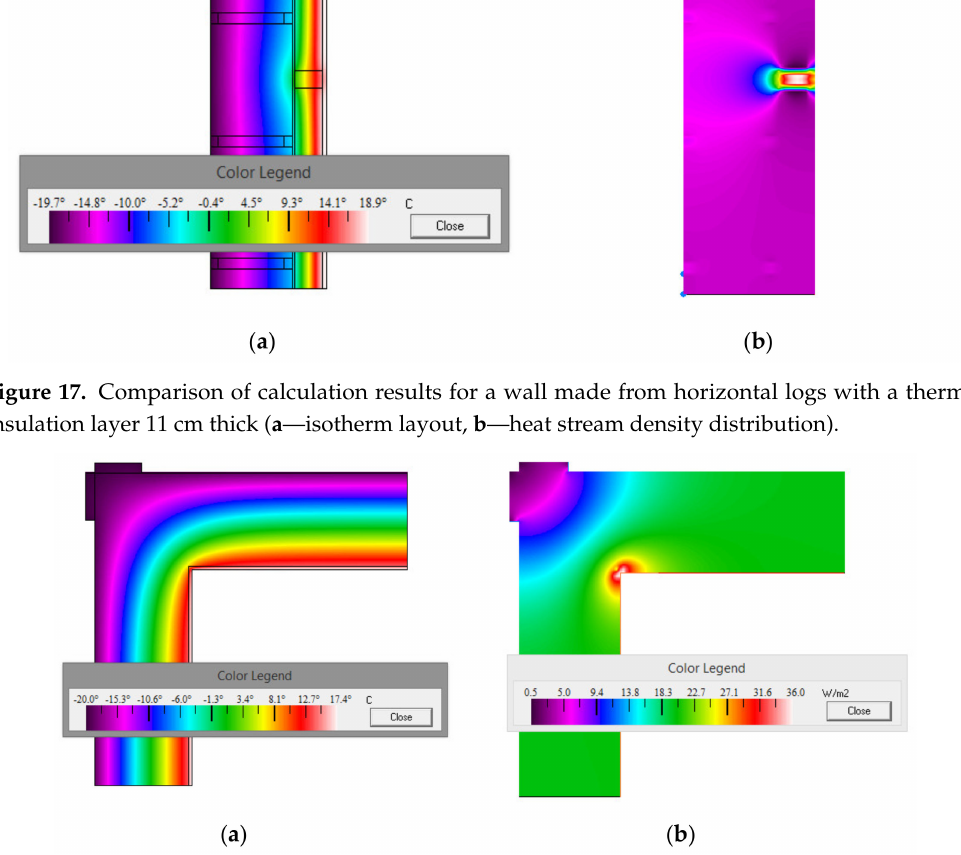
Figure 18. Comparison of calculation results for a wall corner without thermal insulation ( a —isotherm layout, b —heat stream density